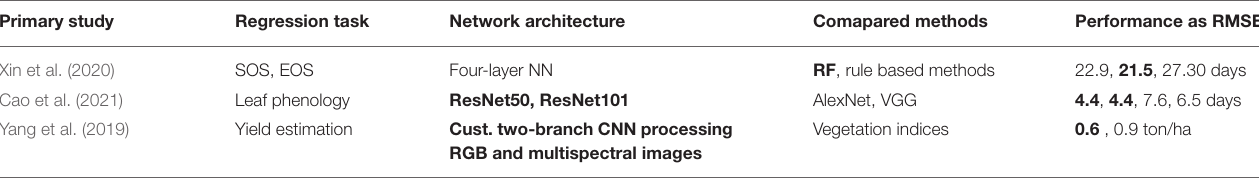
TABLE 7 | Overview of deep learning methods for regression